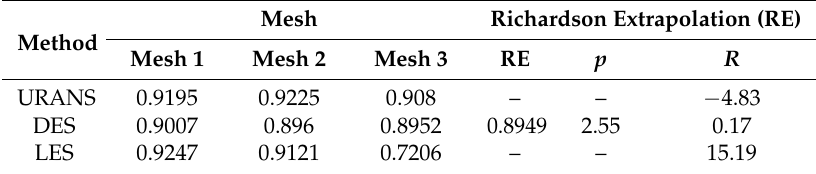
Table 2. Results of the mesh independency study by turbulence calculation method.